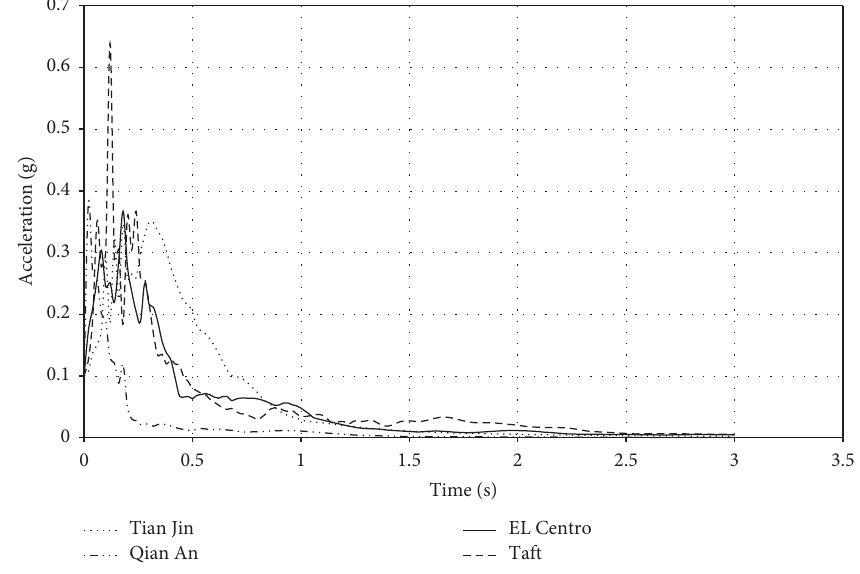
Figure 6: Response spectra of acceleration.